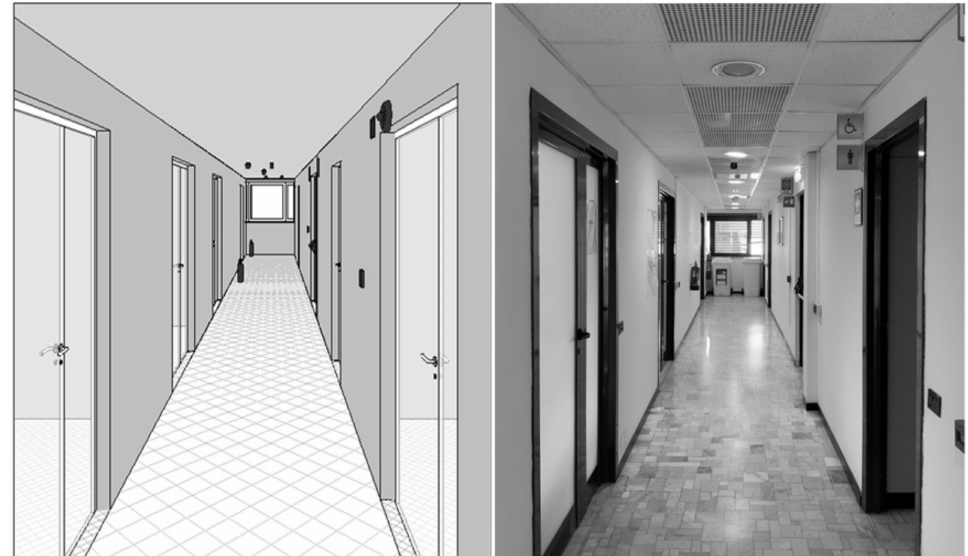
Figure 6. Comparison between the simulation of the virtual sensor field-of-view in the BIM model ( left ) and the actual field-of-view of the installed sensor ( right